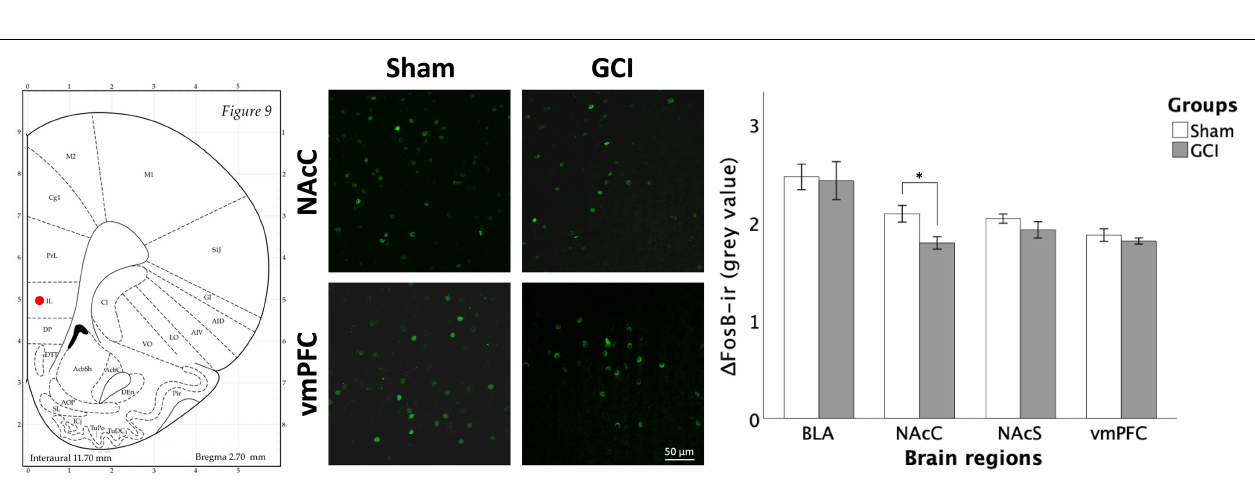
FIGURE 9 | (cid:49) FosB fluorescence immunohistochemistry following GCI. Figure shows representative fluorescence microphotographs of (cid:49) FosB and FosB expression at 20 × magnification in the NAcC and ventromedial prefrontal cortex (vmPFC) of rats having undergone sham surgery or GCI. Histogram presents mean grey value for (cid:49) FosB and FosB immunoreactivity in each studied brain region. Values are presented as mean ± S.E.M. ∗ Indicates statistical significance at p < 0.05. Visual representation of rat brain adapted from labs.gaidi.ca/rat-brain-atlas/ (Paxinos and Watson, 2006). BLA, basolateral amygdala; GCI, global cerebral ischemia; NAcS, nucleus accumbens